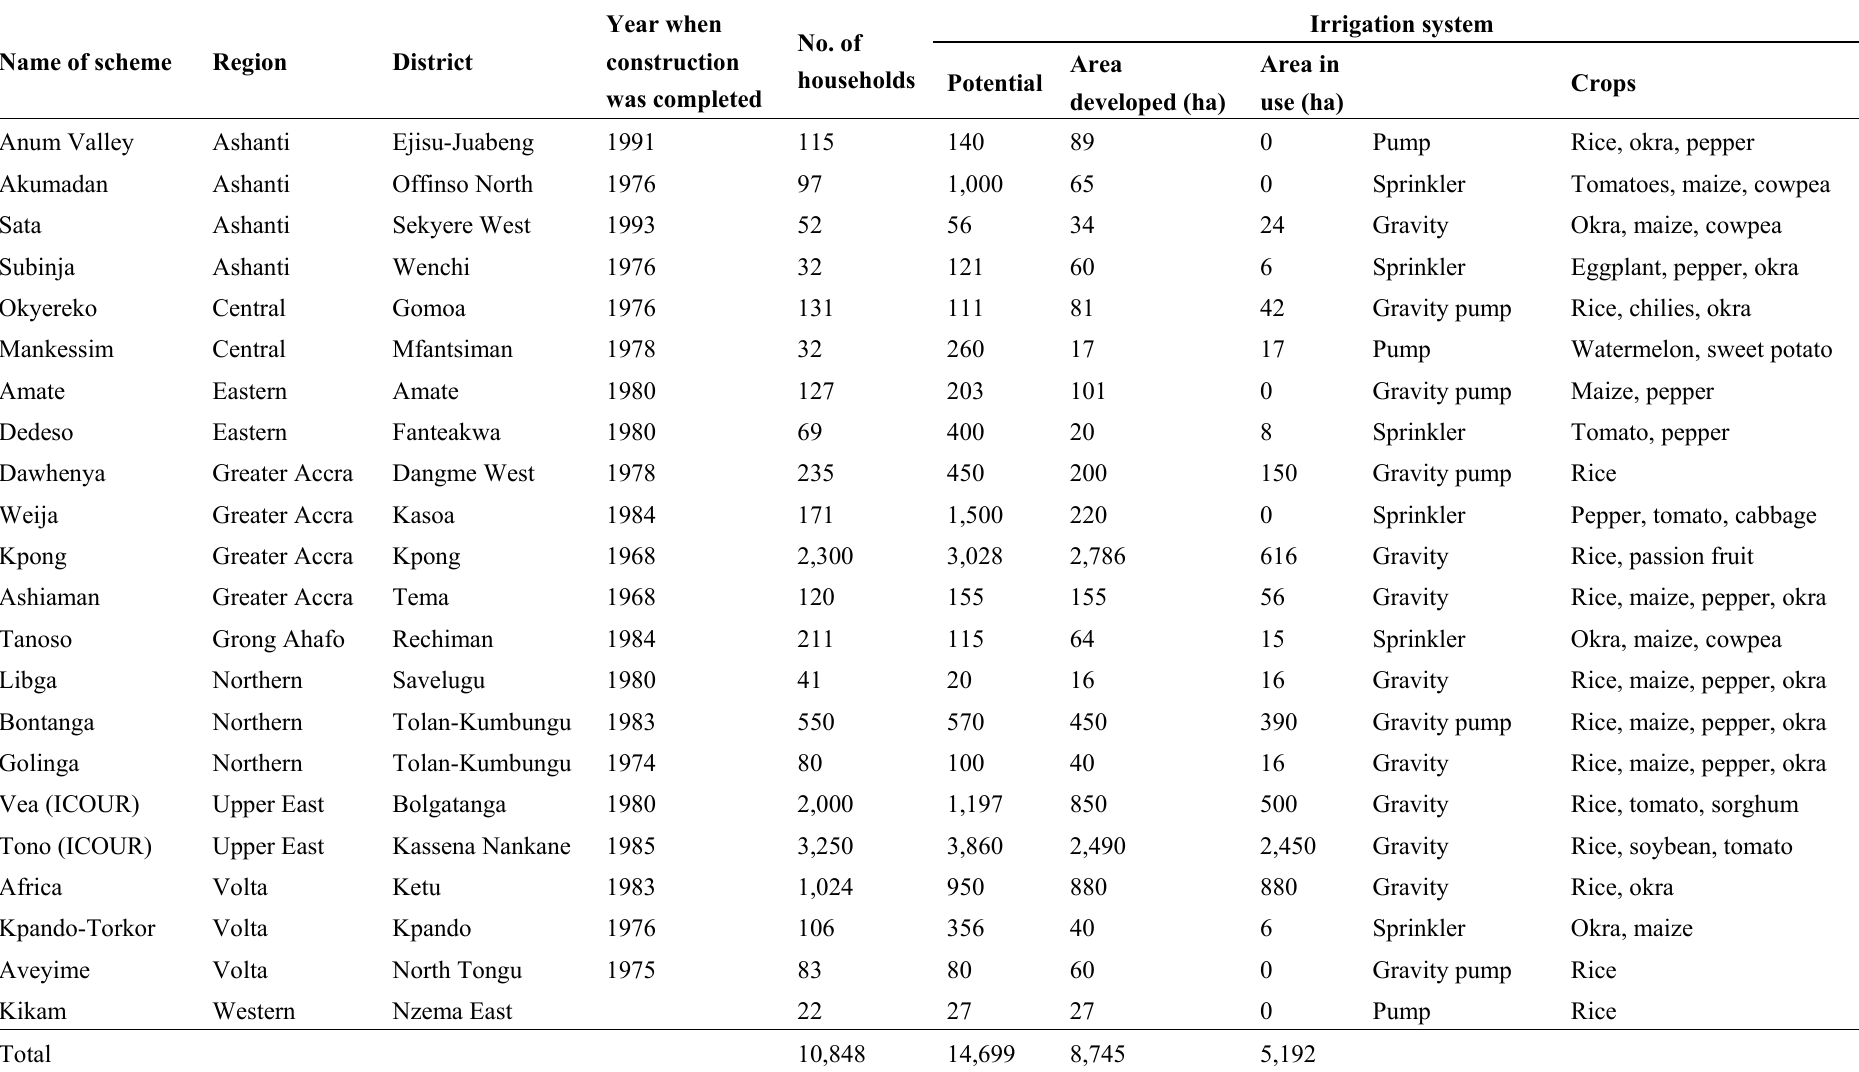
Table 2. Irrigated areas from national statistics (extracted from Ghana Irrigation Development